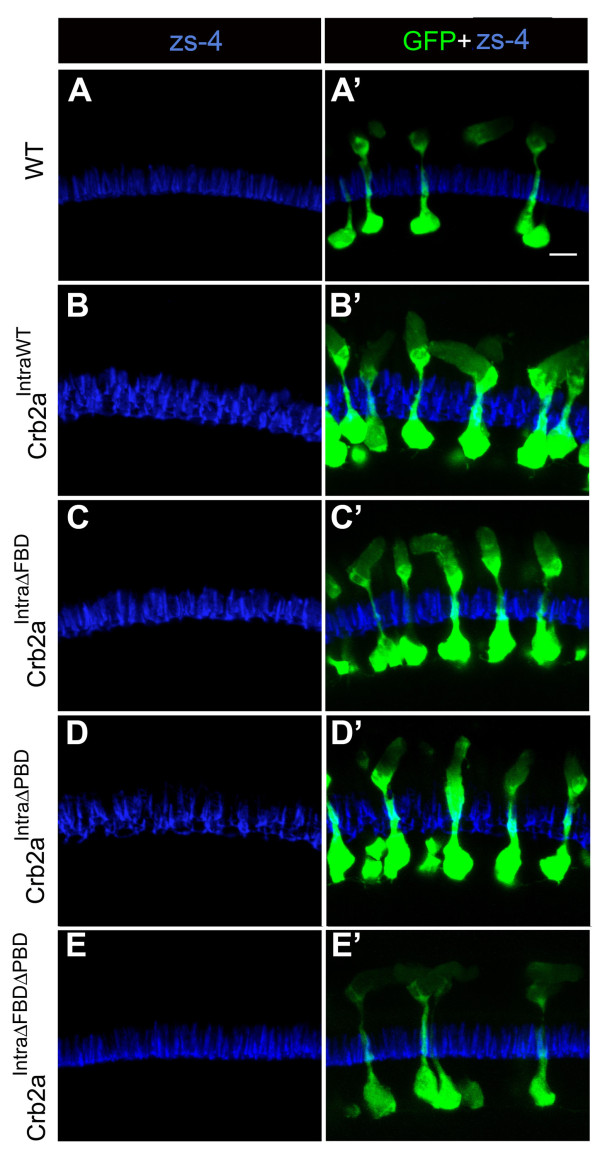
Effects of Crb2a constructs that lack the extracellular domain on endogenous Crb2a. (A-E') Confocal z-projections of 6 d rods labeled with zs-4 (blue) and anti-GFP (green) antibodies. (A, A') Wild-type rods. (B, B') Crb2aIntraWT transgenic rods. (C, C') Crb2aIntraΔFBD transgenic rods. (D, D') Crb2aIntraΔPBD transgenic rods. (E, E') Crb2aIntraΔFBDΔPBD transgenic rods. Scale bar, 5 μm.